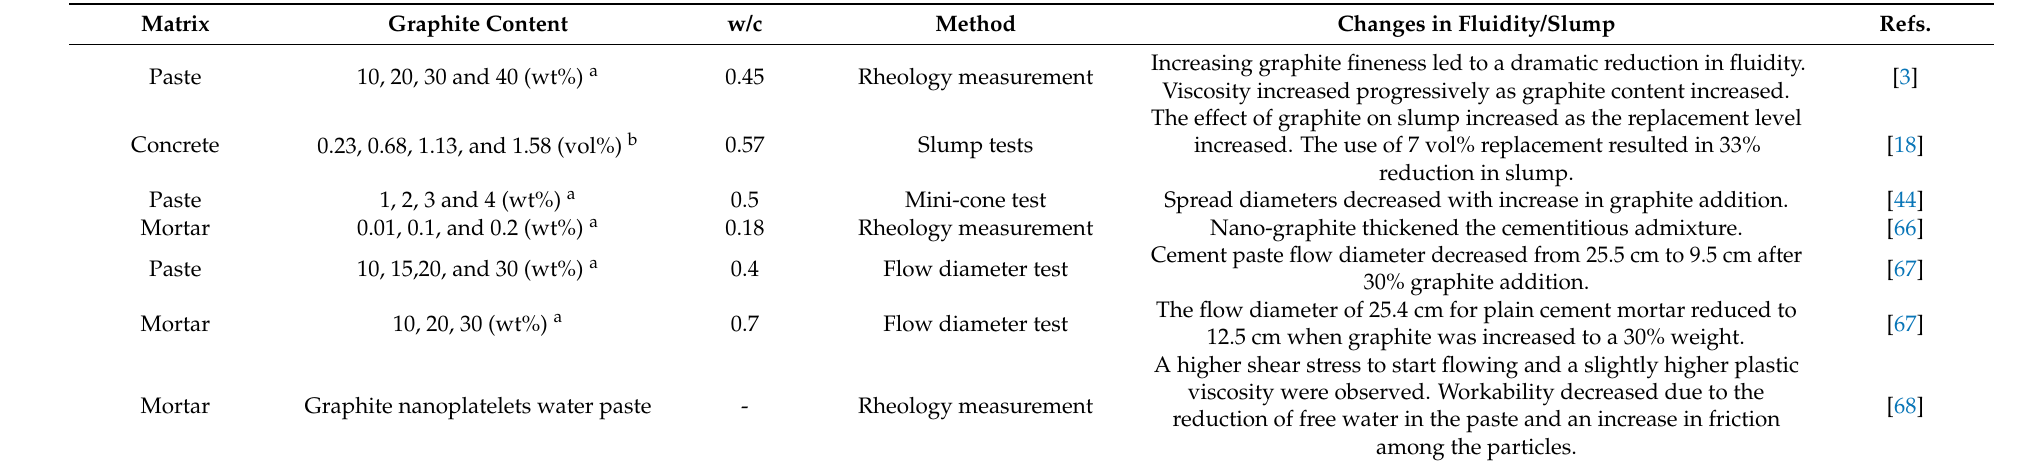
Table 2. Influence of graphite on fresh cement composite